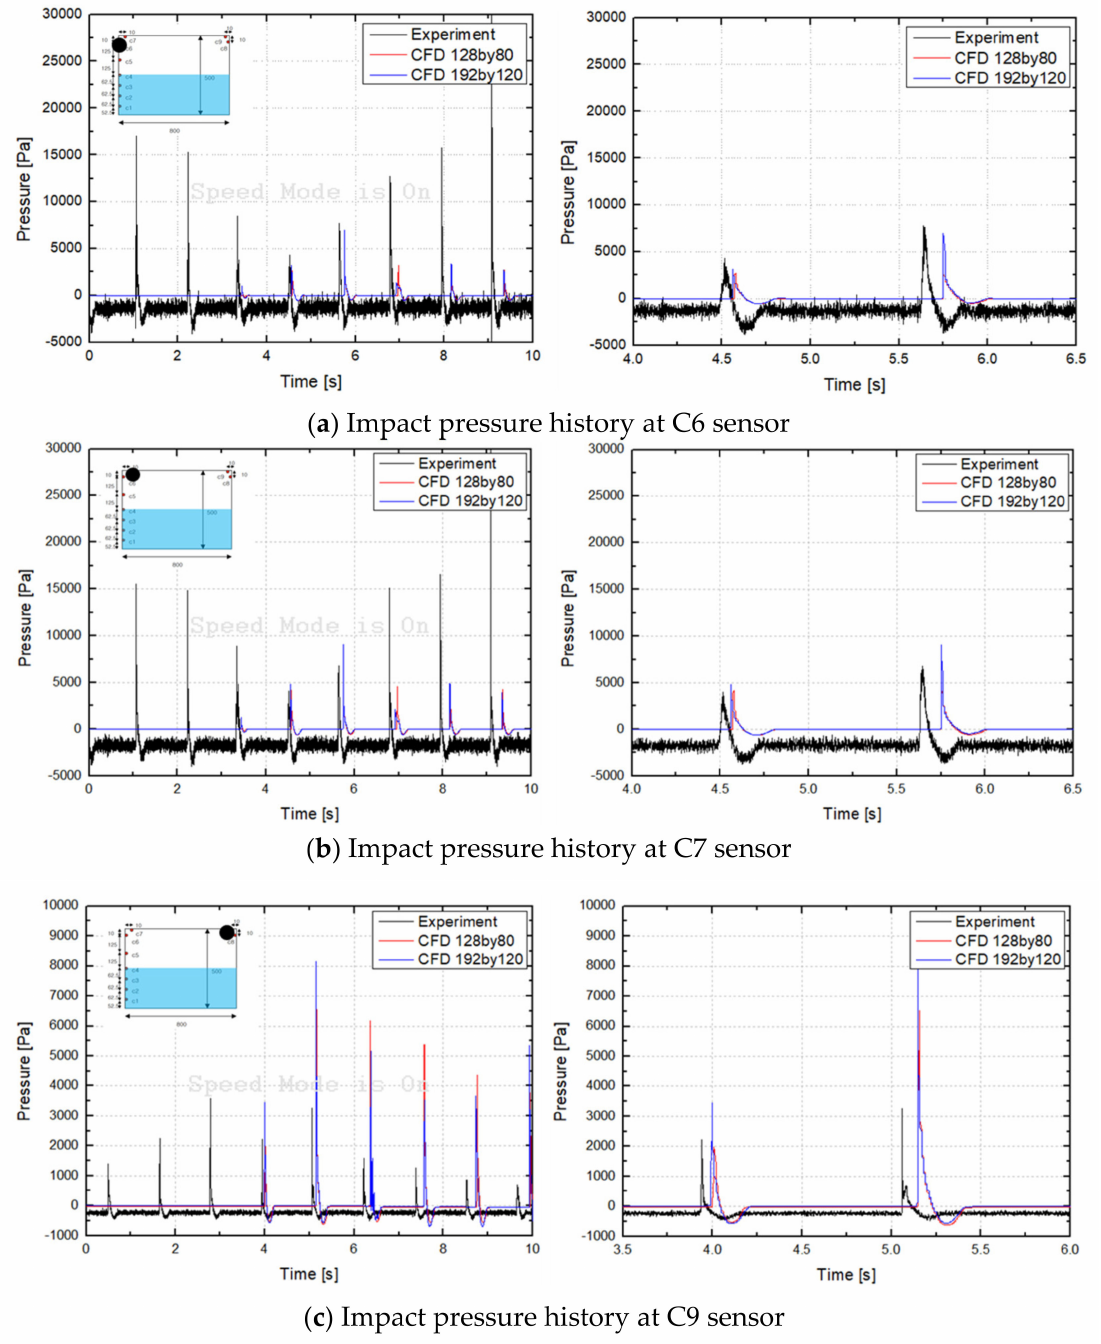
Figure 8. Comparison of impact pressure history between experiment and CFD analysis: at C6 sensor ( a ); C7 sensor ( b ); C9 sensor ( c